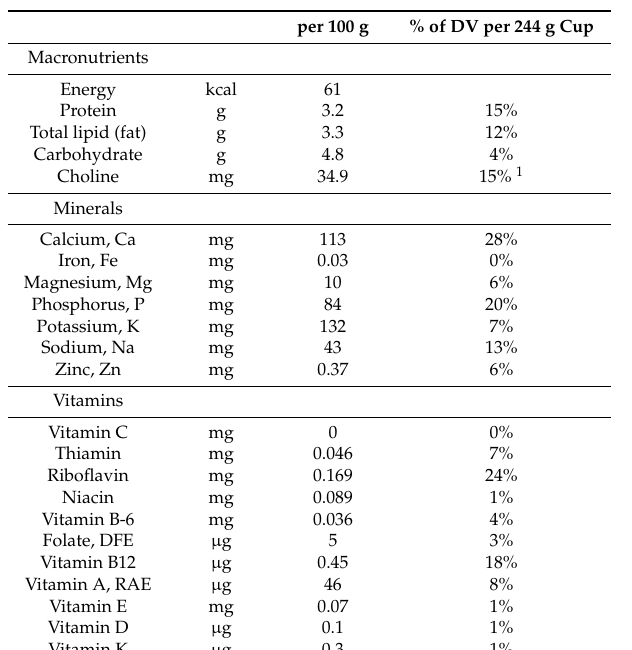
Table 1. The nutritional composition of cow’s milk with 3.25% fat as the % of Daily Value (DV) per 100 g and per 244 g serving